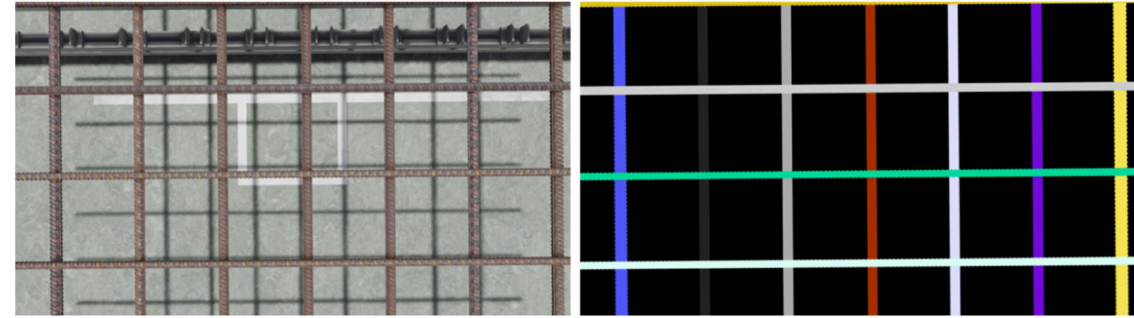
Figure 7. Synthetic image and material ID